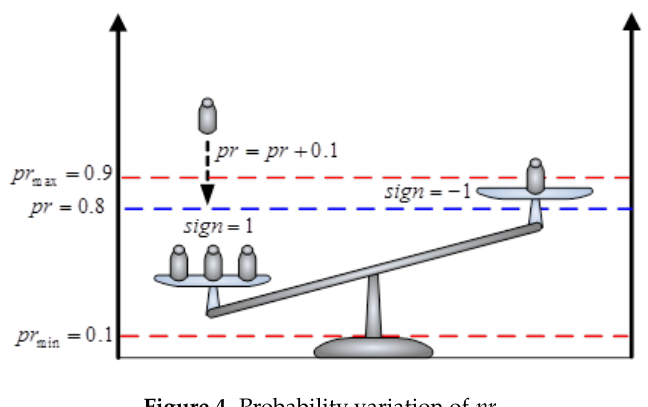
Figure 4. Probability variation of pr .